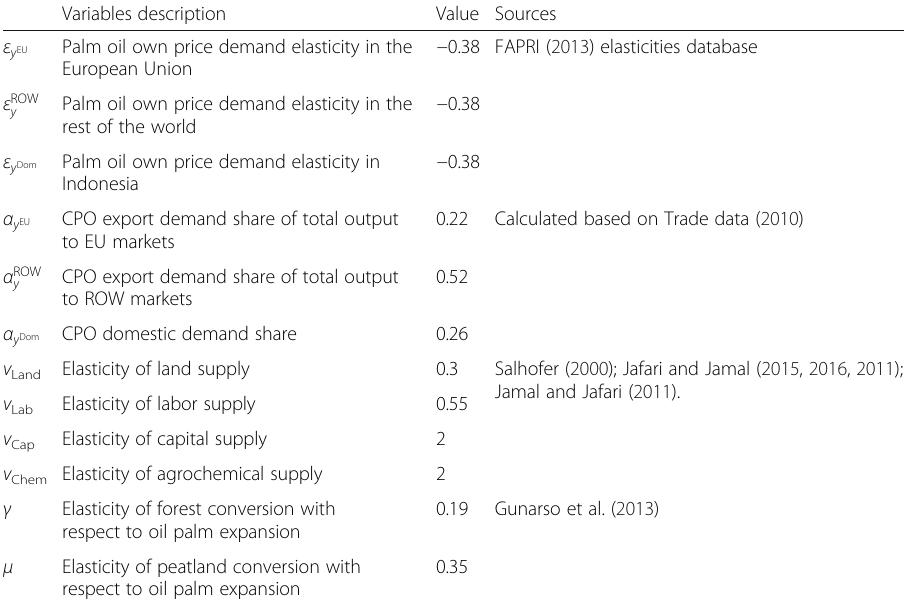
Table 7 Elasticity values, market shares, and conversion rates